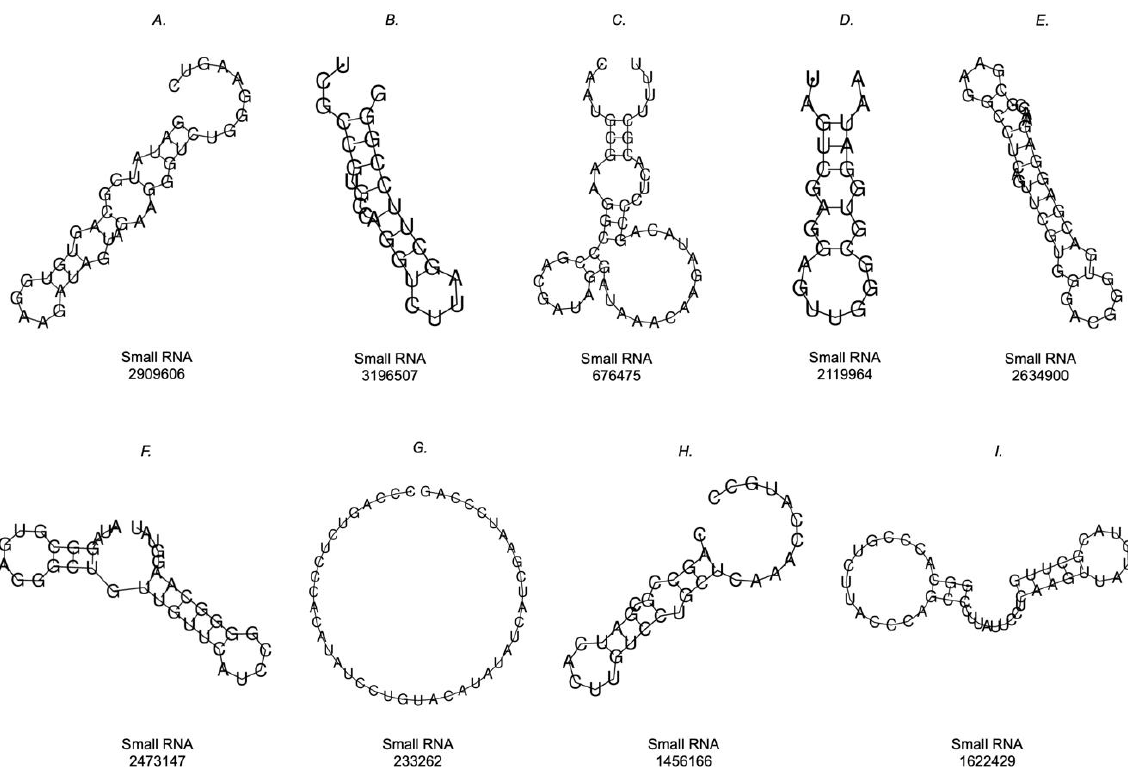
Figure 8. Prediction of the secondary structures of small RNAs that interacted with mRNA LDLR. Simple MFE structure drawings were obtained with RNAfold WebServer.